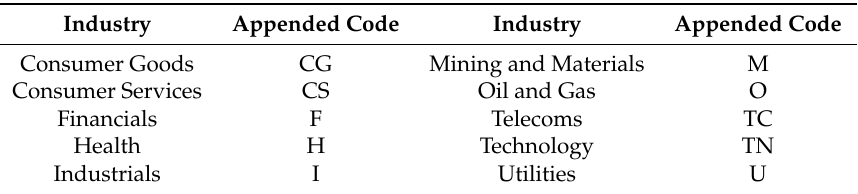
Table 1. Below are listed the one or two letter industry designations that were appended to a stock’s three letter ticker symbol to indicate the main industry within which it operates. The industry groups were assigned by the exchange and are used in Figures